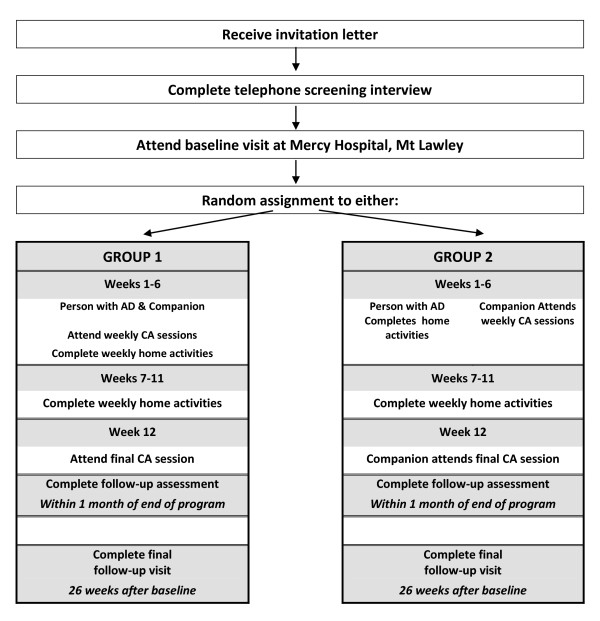
Baseline assessment